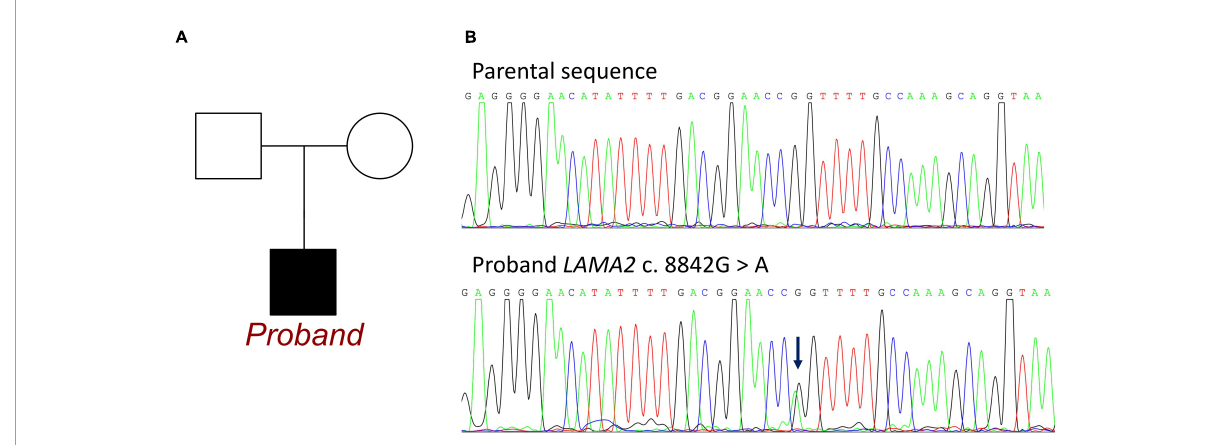
FIGURE2 Information of LAMA2 c.8842G > A in the family of the proband. (A) Family map of gene mutation. (B) Sequencing of mutations. Blue arrow: The normal group showed single peak of base G, while the patient showed heterozygous state of base G peak and A peak.